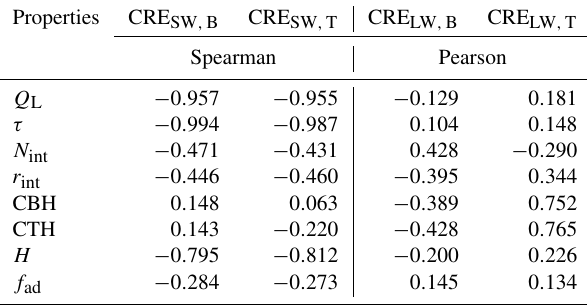
Table 9. Correlations between the cloud radiative effects for the ref- erence simulation (ref.) and the cloud properties. For the SW (LW) radiation, results are presented in the case of the Spearman (Pear- son)